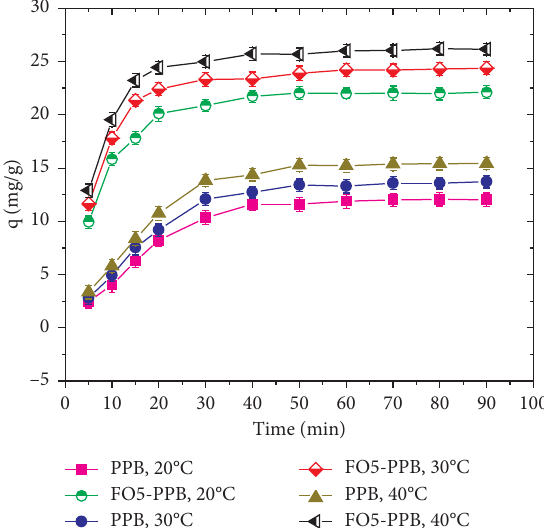
Figure 7: The effects of contact time on RR21 adsorption onto PPB and FO5-PPB. Experimental conditions: pH: 3; initial concentra- tion: 50 mg/L; adsorbent dose: 2g/L; temperature: 25 ± 2 ° C.